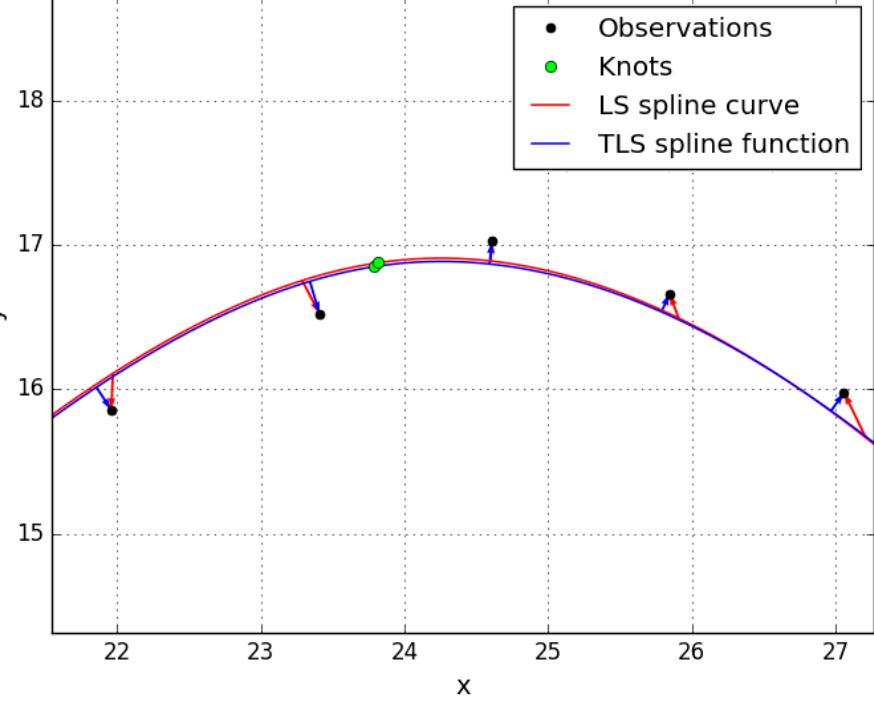
Figure 4. Magnification of the area marked by a rectangle in Figure 3.